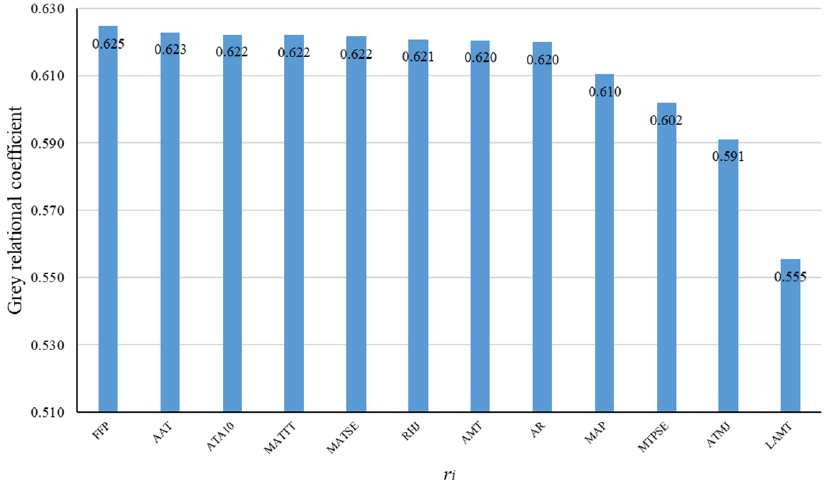
Figure 3. The grey correlation coefficient between twelve meteorological factors and yield (variables in the figure present twelve meteorological factors after standardized treatment).